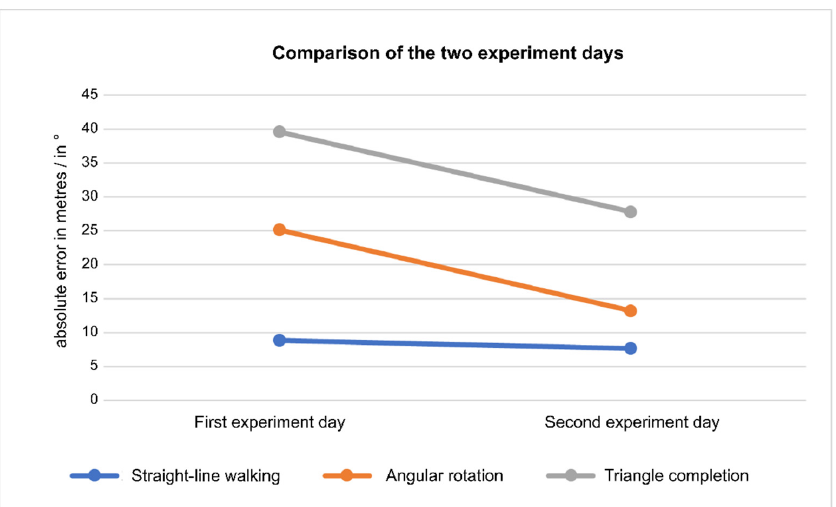
Figure 11. The mean absolute errors of the three experimental tasks straight-line walking (blue), angular rotation (orange) and triangle completion (grey) on the first and on the second experiment day are depicted. In the case of the straight-line walking task, the absolute error is the distance missing to the finishing line (in m). For the angular rotation task and the triangle completion task the absolute error is the absolute turning error (in °).